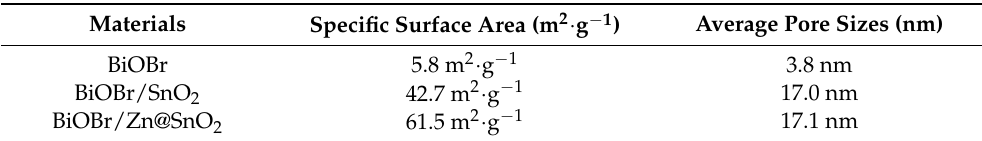
Table 1. Specific surface area and average pore sizes.